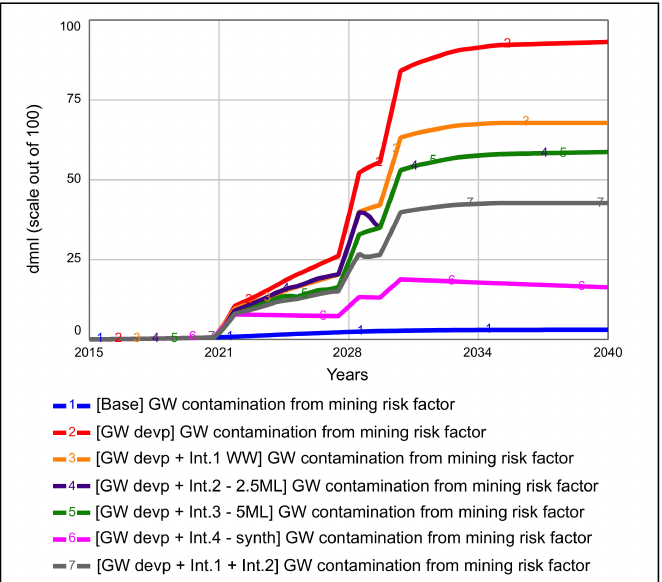
Figure 10. The final comparison of scenarios of groundwater development in relation to the four interventions. The variable displayed is the cumulative ‘GW contamination from mining risk factor’, measured as a dimensionless index (dmnl) scaled out of 100 (the higher the risk factor, the more groundwater abstracted for the BRC is at risk). Note that the x -axis is shortened to only display the results from 2015–2040 in order to enhance the legibility of the